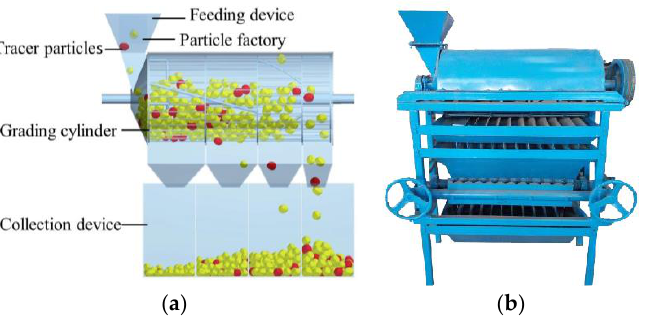
Figure 10. Comparison between the simulation test and physical test of walnut classification. ( a ) Physical test; ( b ) Simulation test.